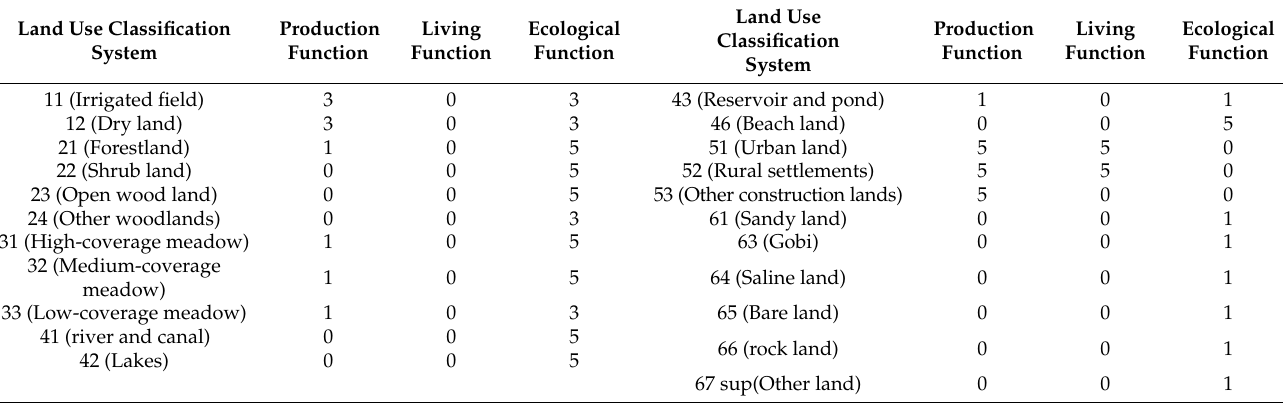
Figure 2. Land use maps in 1990, 2005, and 2018 of Henan Province. Table 1. Evaluation assignment table of territorial spatial functions.